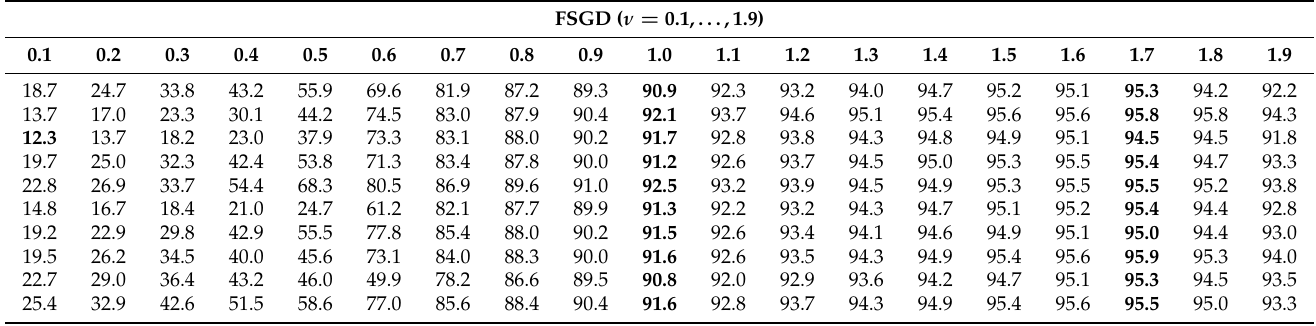
Table 2. Comparison between SGD and FSGD. The case ν = 1.0 matches with SGD. FSGD ( ν = 0.1,. . .,1.9)